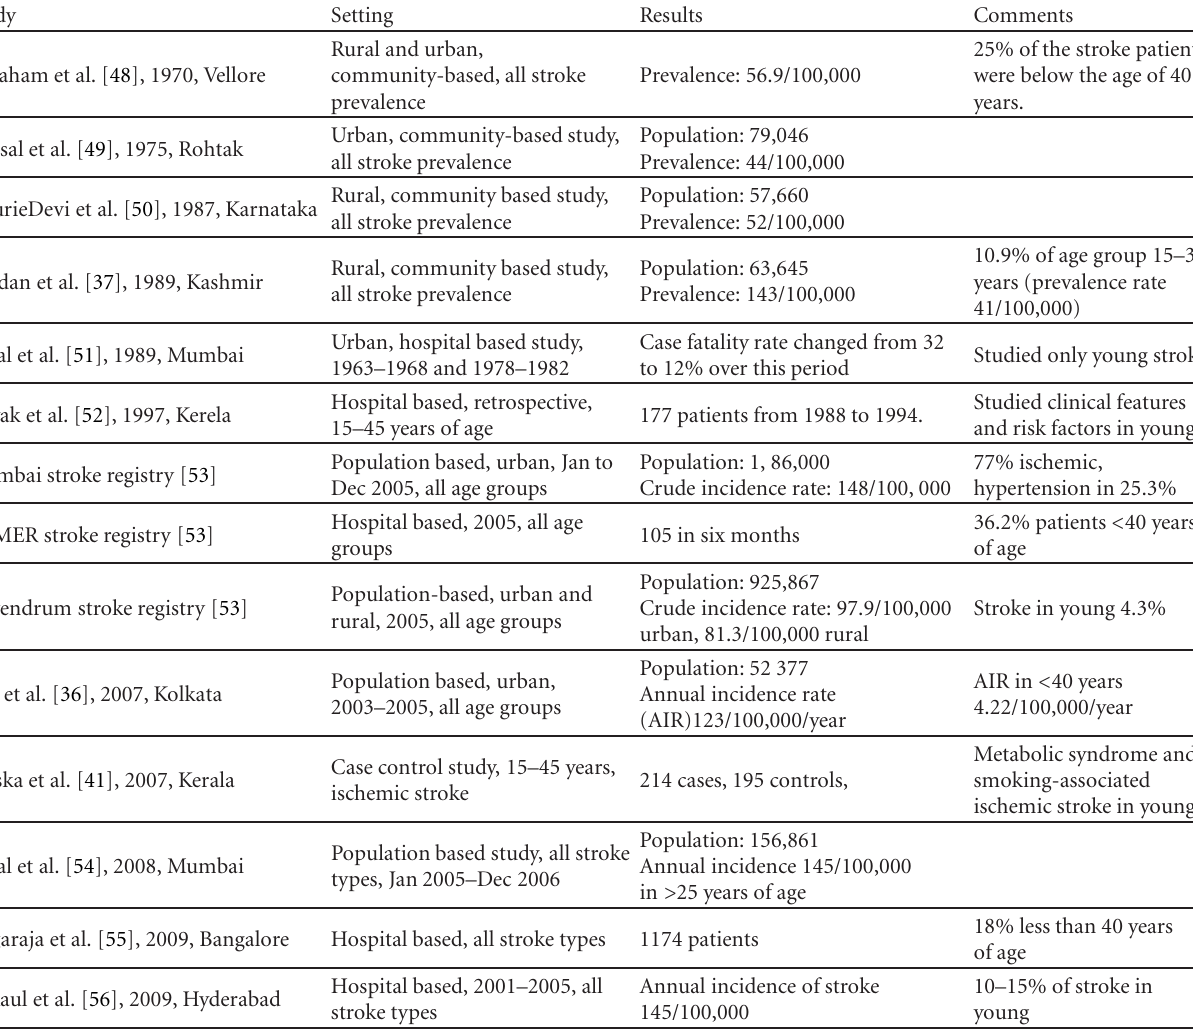
Table 4: Studies on stroke conducted in